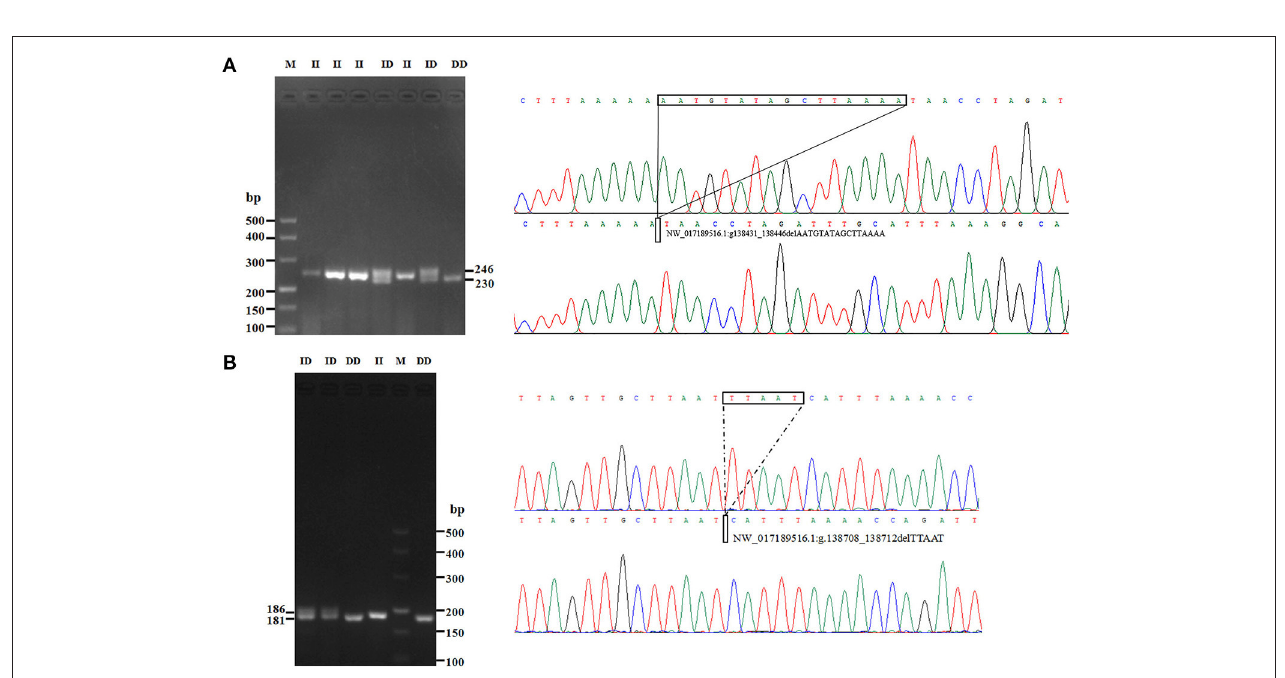
FIGURE 3 | The electrophoresis diagrams and sequence diagrams of goat KDM6A gene indel loci. (A) 16 bp indel locus. (B) 5 bp indel locus.